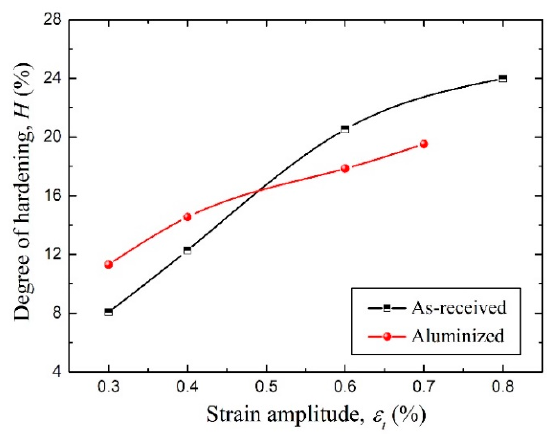
Figure 12. Dependence of the degree of cyclic hardening on imposed strain amplitude.